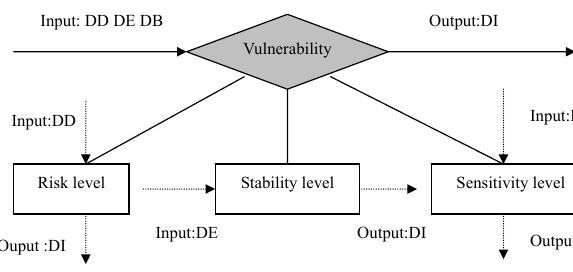
Fig.2.The flood disaster system and its vulnerability